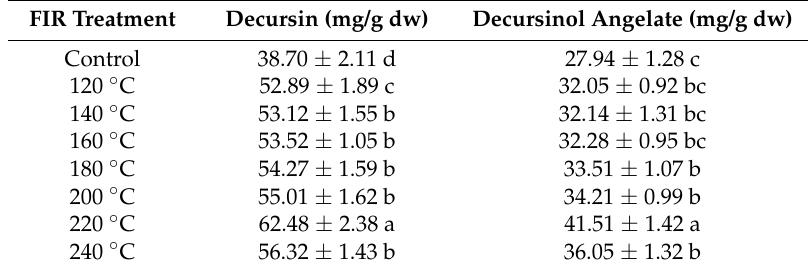
Table 2. HPLC quantification of decursin and decursinol angelate content of A. gigas Nakai treated by FIR